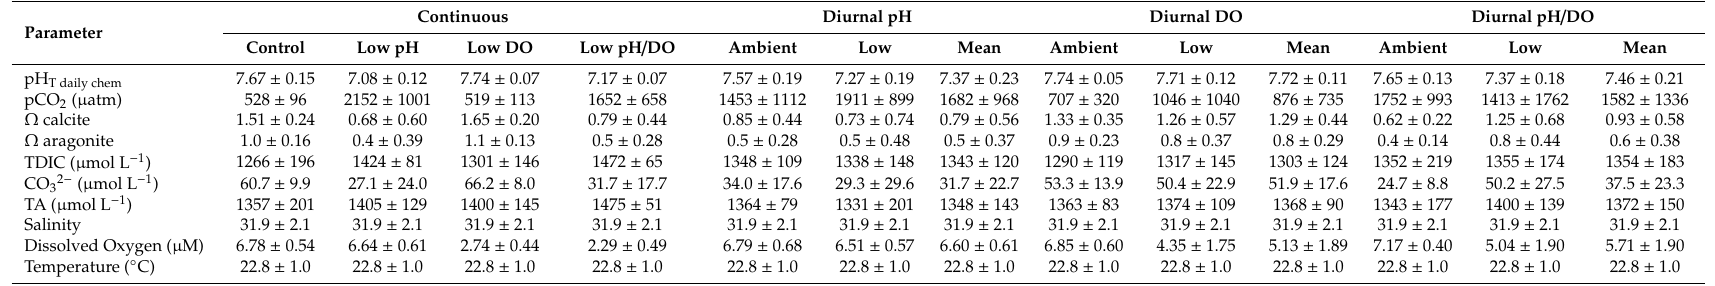
Table 3. Mean ( ± standard deviation) pH, pCO 2 , saturation states of calcite and aragonite, total dissolved inorganic carbon (TDIC), carbonate, total alkalinity (TA), salinity, dissolved oxygen, and temperature for the Cyprinodon variegatus seven treatment diurnal acidification and hypoxia experiments. Parameter